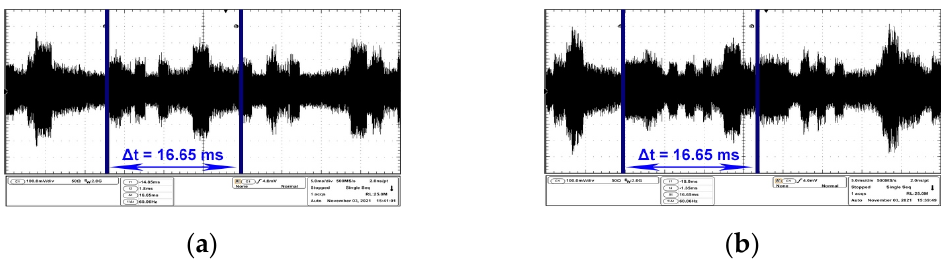
Figure 5. HP display: ( a ) frame period corresponding to an image containing three black equal stripes on white background; ( b ) frame period corresponding to an image containing one thick black stripe and three thin black equal stripes on black background.